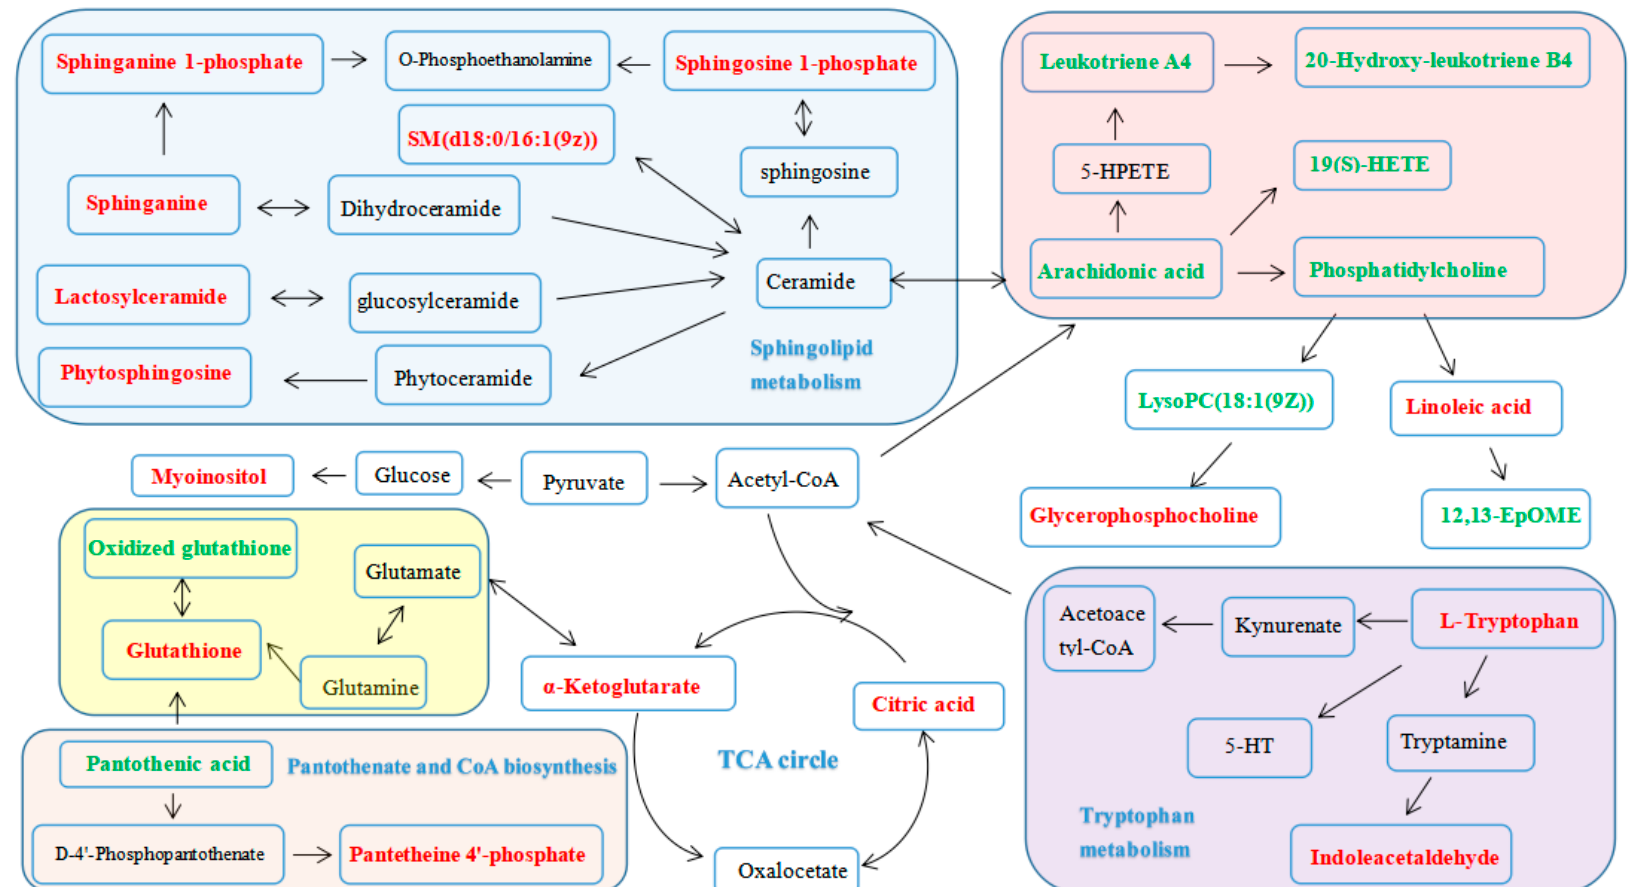
Figure 12. The metabolic pathways of serum and the hippocampus. (Red labeled metabolites: potential biomarkers with increased levels in the HPF group, compared to the M group. Green labeled metabolites: potential biomarkers with decreased levels in the HPF group, compared to those of the M group).